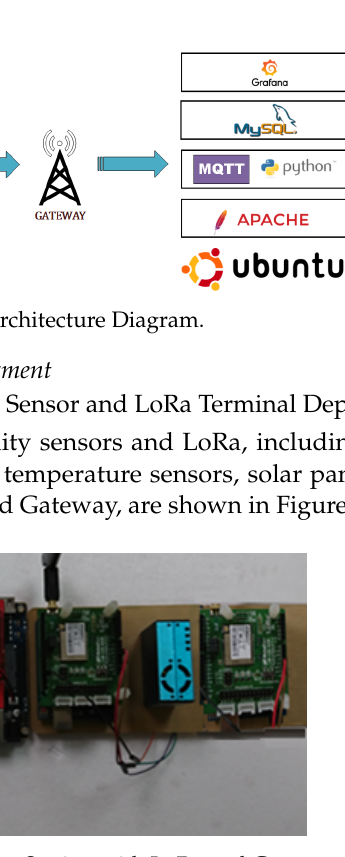
Figure 5. Monitoring Station with LoRa and Gateway.